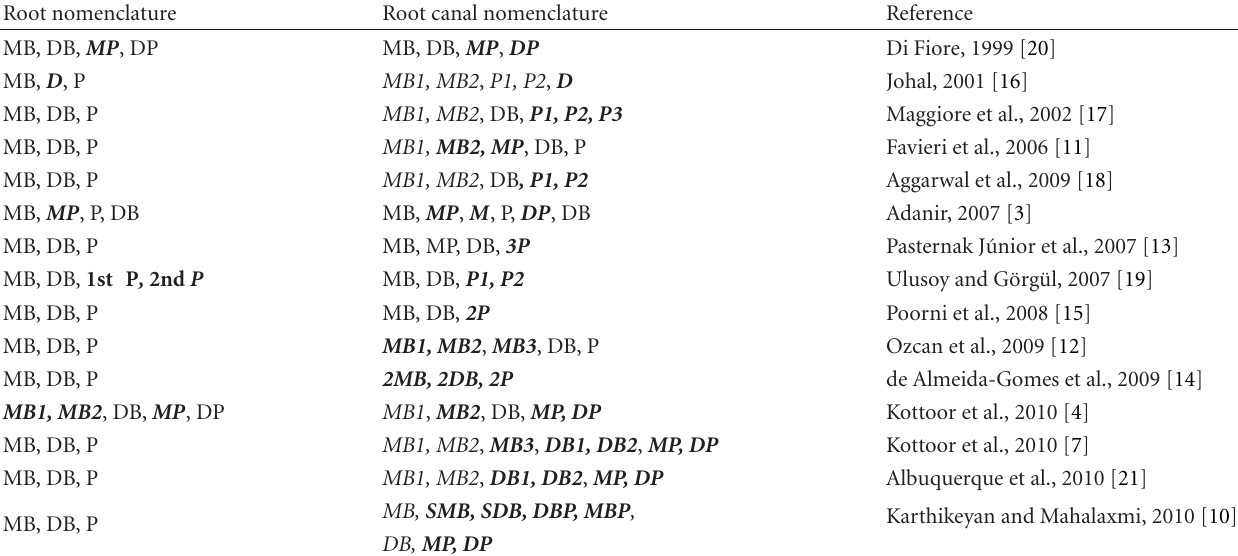
Table 1: Variations of roots and the canal anatomy of maxillary molars, as reported by various authors, with the numerous terms that have been used to name these